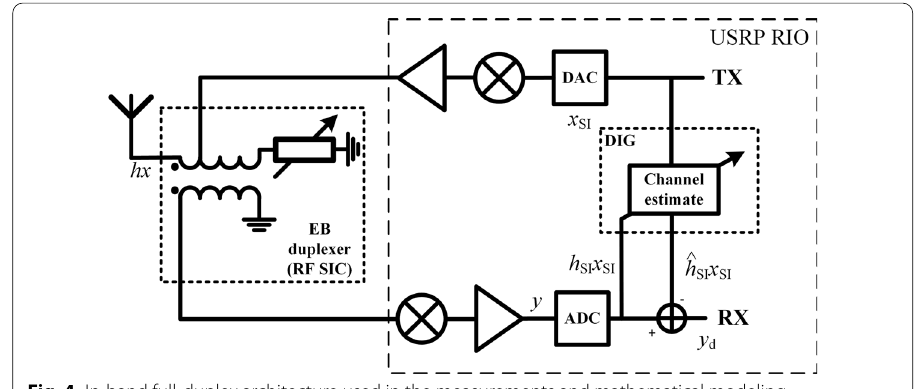
Fig. 4 In-band full-duplex architecture used in the measurements and mathematical